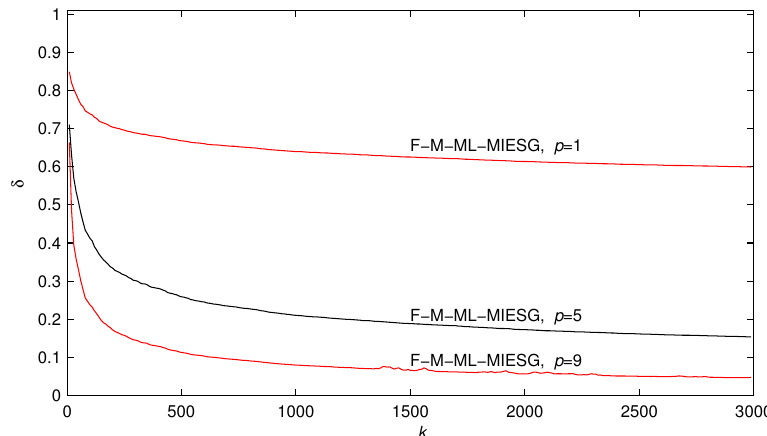
Figure 6. The F-M-ML-MIESG estimation errors versus k with different innovation lengths ( σ 2 = 0.10 2 ).